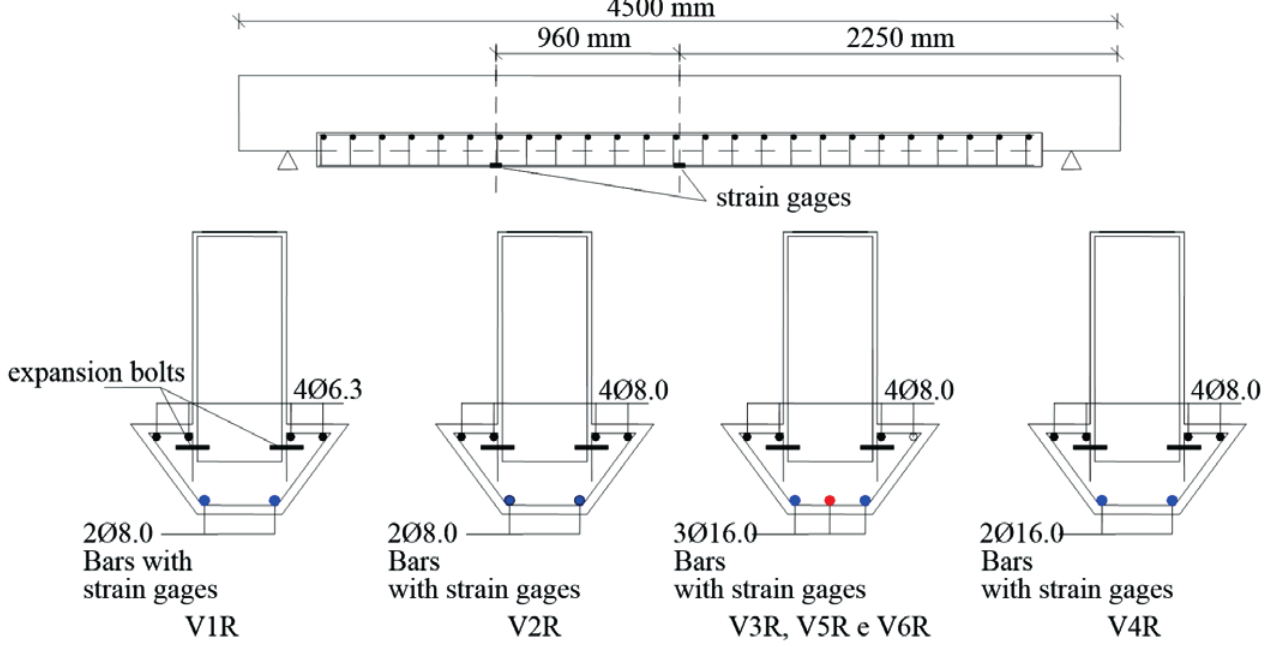
Cross-section of strengthened beams and strain gauges positions on longitudinal tensile reinforcement of the